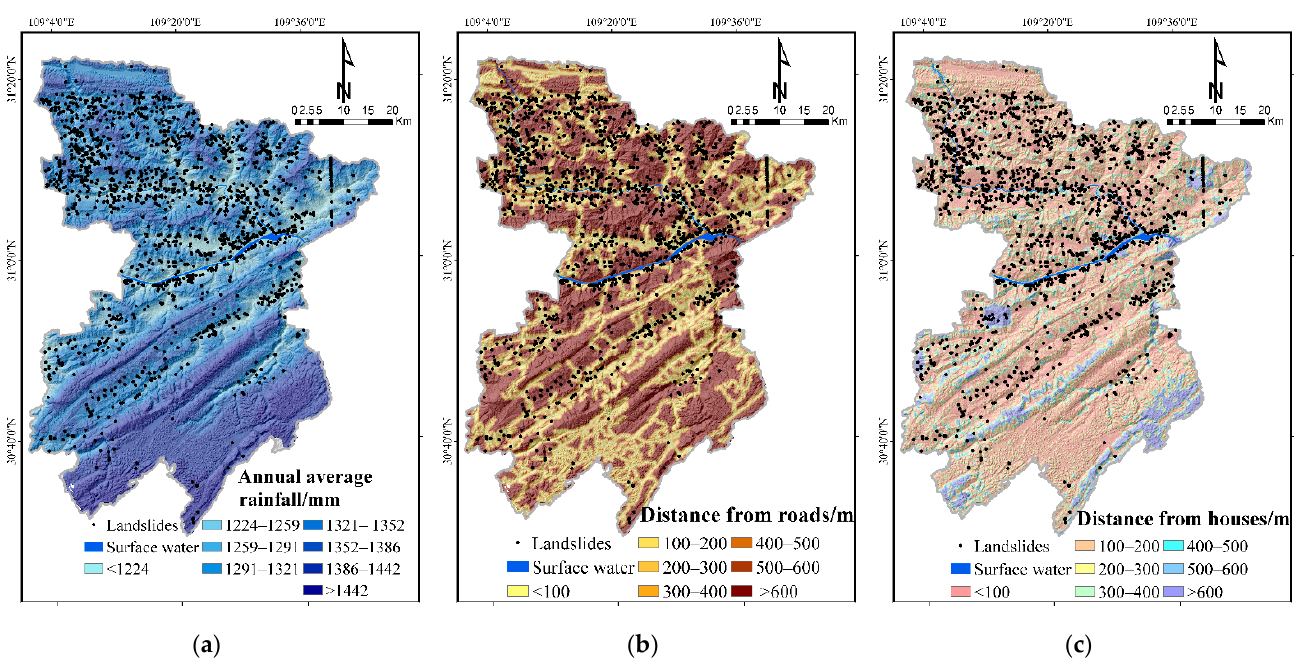
Figure 6. Triggering factors Layer of Landslide Hazard: ( a ) Annual average rainfall; ( b ) Distance from roads; ( c ) Distance from houses.